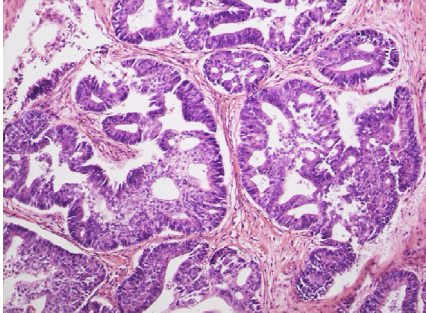
Figure 1: Adenocarcinomas are arranged in irregularly glandular and tubular or cribriform pattern, showing morphology of endometrioid carcinoma. Hematoxylin and eosin staining